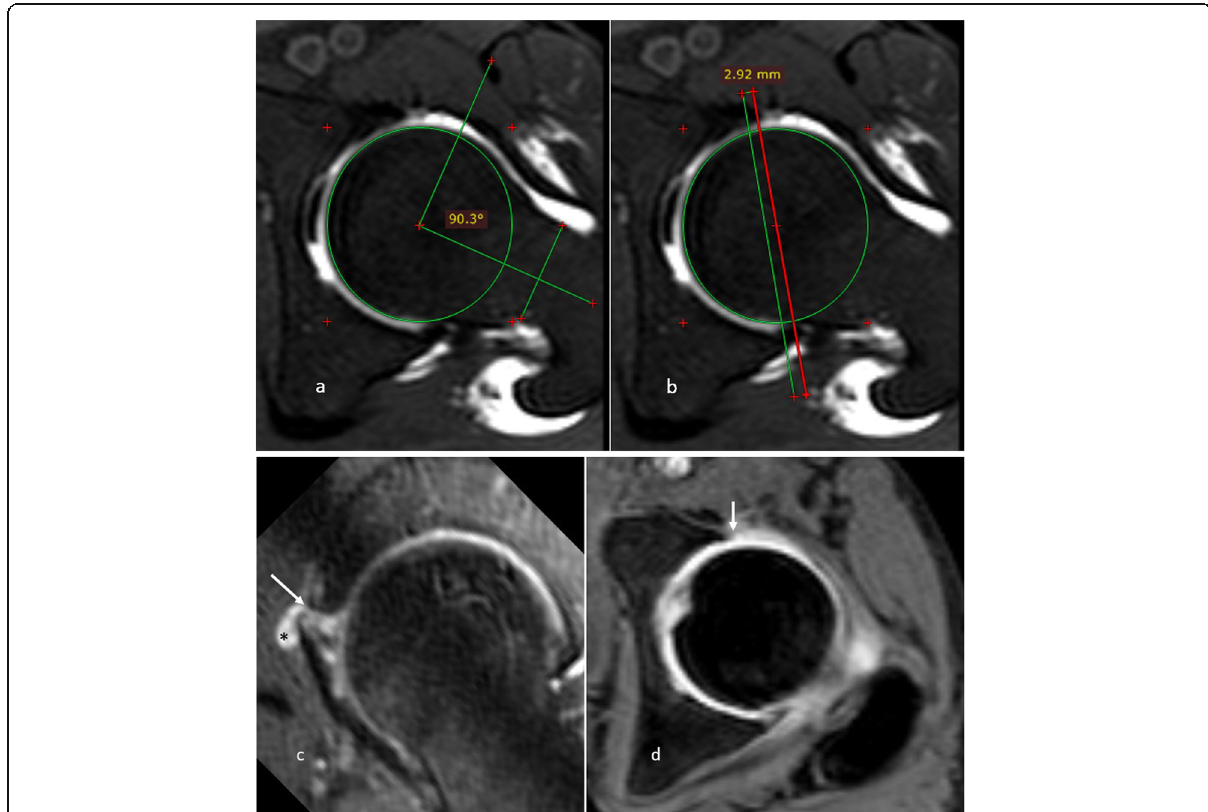
Fig. 6 Femoroacetabular impingement (cam type) in a 39-year-old male, complaining of left hip pain and limitation of movement. a , b Axial oblique T1 fat sat post-contrast: a increased alpha angle (90.3°), b normal acetabular depth (+ 2.9 mm). c , d Sagittal and axial T1 fat sat post-contrast: c anterior labral complete tear with detachment of its acetabular attachment (arrow in c ) and appear defective on axial images (arrow in d ) together with paralabral cyst (asterisk in c